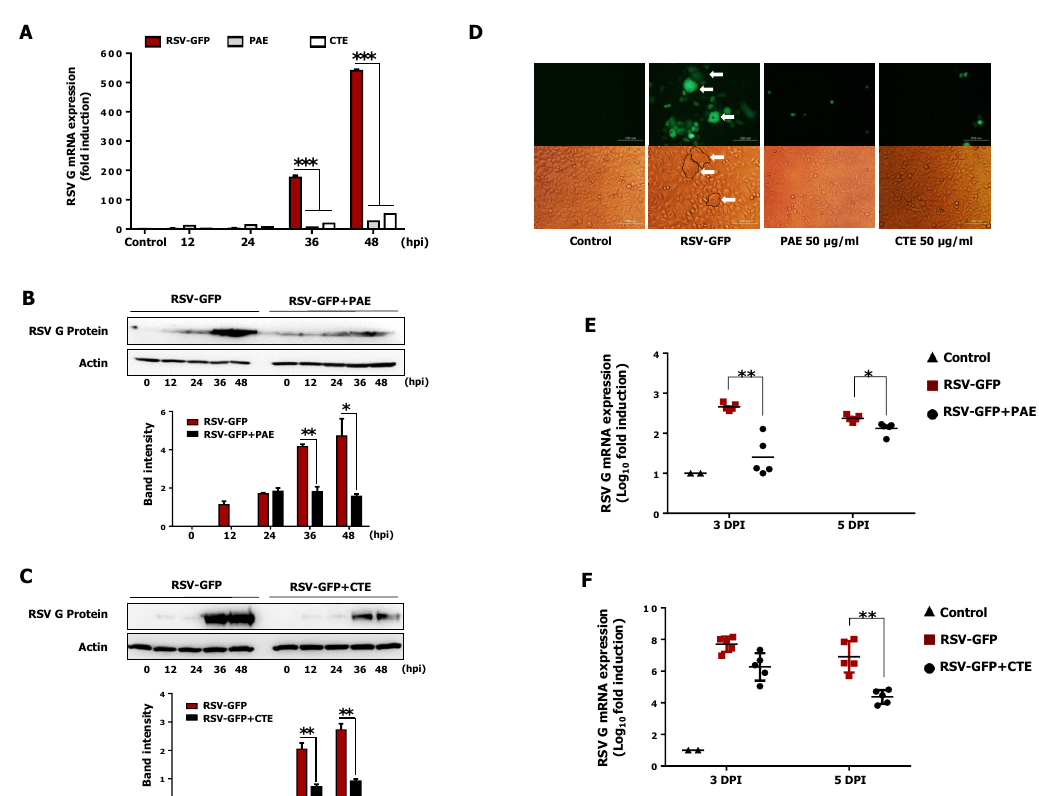
Figure 4. Reduction of RSV Glycoprotein (RSV-G) gene transcription, protein translation and syncytium formation in-vitro and inhibition of RSV replication in-vivo by PAE and CTE. HEp2 cells were seeded in six well cell culture plats and incubate for 12 h. Medium was changed into DMEM containing 1% FBS and RSV-GFP (0.1MOI) was infected for 2 h. Then cells were treated with 50 µ g / mL PAE or CTE. ( A ) Cells were harvested at indicated time points, and RSV-G protein mRNA level was measured at 12, 24, 36, 48 hpi by qRT-PCR, Glyceraldehyde 3-phosphate dehydrogenase (GAPDH) was used for the normalization. ( B , C ) Immunoblot analysis was performed using cell lysates harvested at indicated time points to measure RSV-G protein and β -actin protein expression level time-dependently. The intensity of the RSV-G was quantified. ( D ) Cell and the GFP image were taken at 48 hpi to see the syncytial formation inhibition by PAE and CTE (400 × magnification). ( E , F ) Five weeks old (16 g / mice) BALB / c mice ( n = 5) were intranasally infected with RSV-GFP (1 × 10 6 PFU / mice) in the total volume of 28 µ L. PAE or CTE were orally administrated at a dose of 200 µ L / mice (0.5 mg / mL) at 6, 12, 18 and 24 hpi. At 3 and 5-day post infection (dpi), lung tissues were collected, and the transcription level of RSV-G protein mRNA was determined by qRT-PCR. The arrow indicates the RSV syncytium formation in HEp2 cells. mRNA expression, band intensity expressed as mean ± SD. Error bars indicate the range of values obtained from three independent experiments. In vivo experiment was performed in duplicate. (* p < 0.05, ** p < 0.01 and *** p < 0.001 regarded as significant di ff